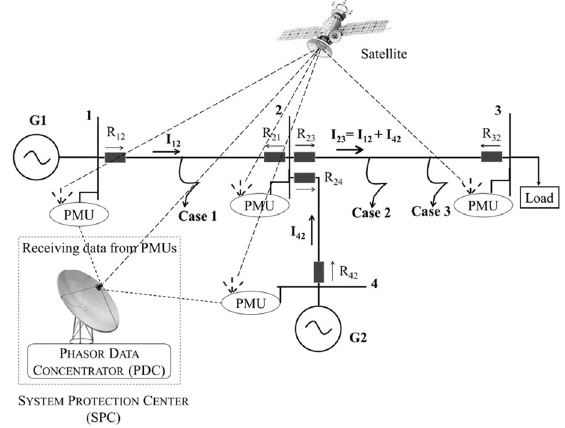
Fig. 2 A four-bus model implemented in PSCAD/EMTDC software to illustrate the functioning of the distance relays during infeed